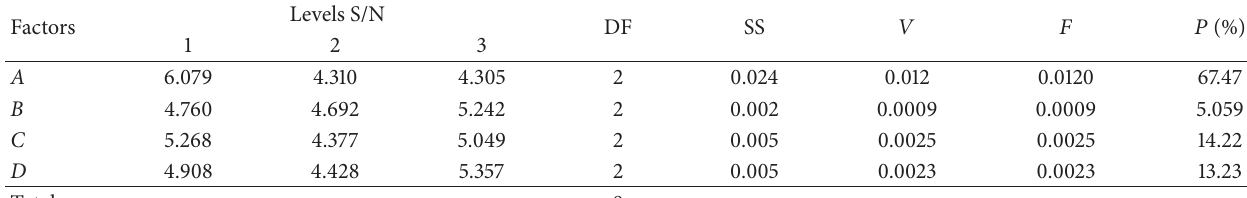
Table 9: ANOVA for coefficient of